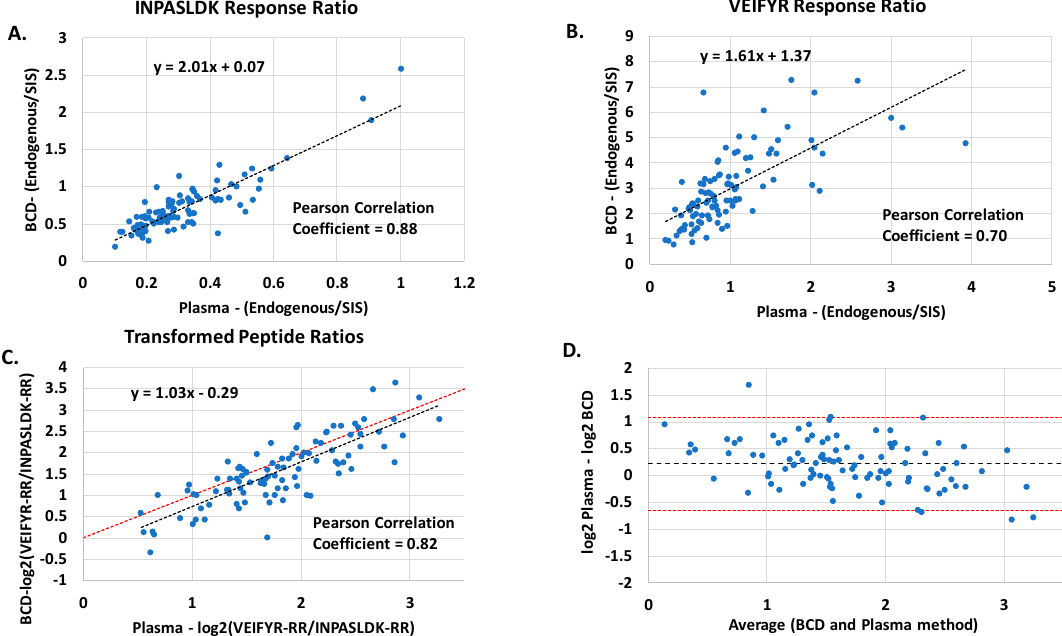
Figure 5. Peptide comparison between the BCD-collection method and plasma-collection method A. RR of peptide INPASLDK B. RR of peptide VEIFYR. C. Comparison of the peptide ratios RR for the two methods after the applied correction factor. The dotted red line represents the identity line. D. The corresponding Bland-Altman Plot for the method comparison, the red dotted line represents the 95% confidence internal.